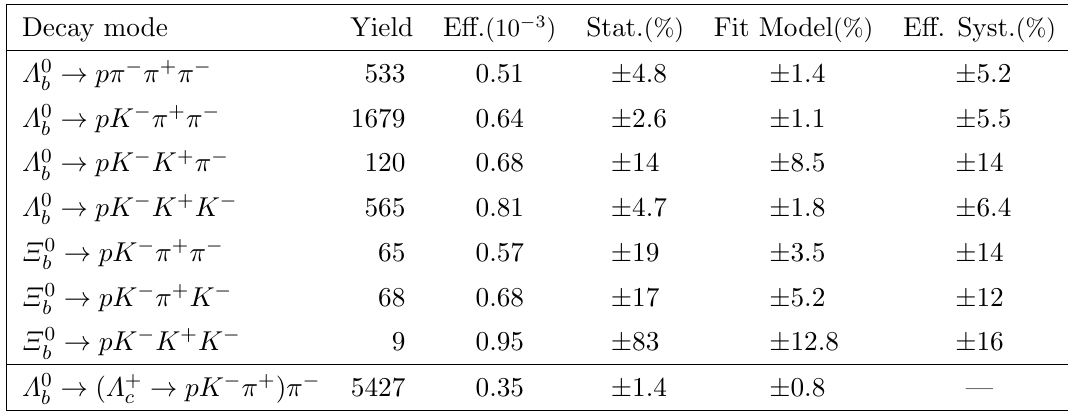
Table 3 . Yields and e(cid:14)ciencies of each signal decay with the statistical uncertainty, and systematic uncertainties related to the (cid:12)t model and the e(cid:14)ciency determination, for the 2011 data